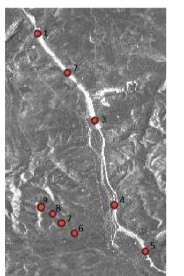
Figure 5. Distribution of deformation points selected in the study region The elevation information and deformation information of each extracted deformation point corresponding to the different time is shown in the Table 2.